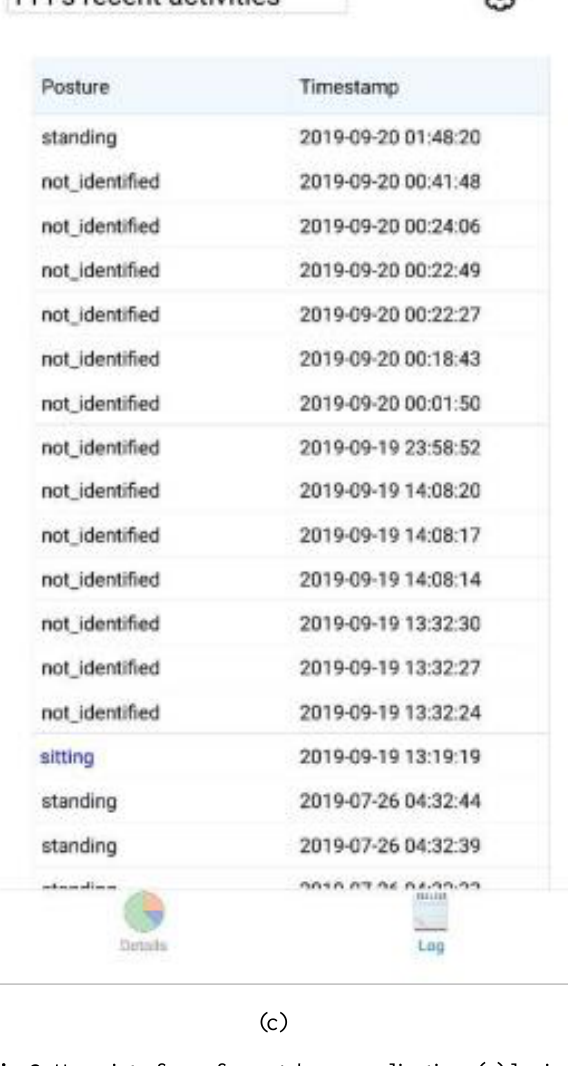
Fig. 3. User interface of smartphone application, (a) login interface, (b) Interface for statistical analysis of user activities (c) Log of posture and activity recognition